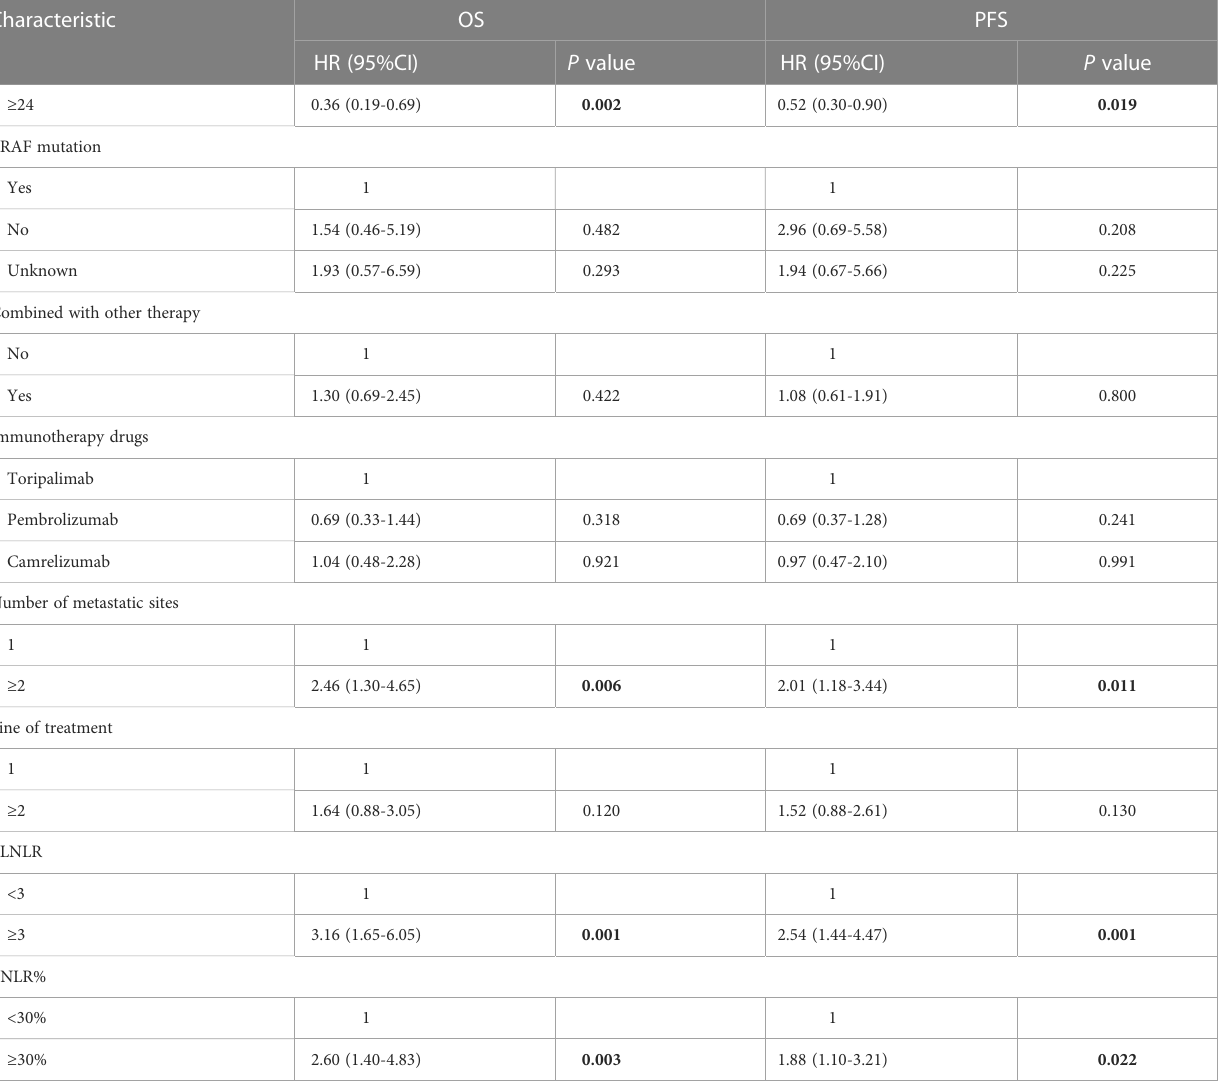
In a multivariate Cox regression model, BLNLR, D NLR%, BMI and number of metastatic organs were independent prognostic factors for OS (Table 3). The risk of mortality in the high-BLNLR group was 2.58 times higher than that in the low-BLNLR group (HR: 2.58, 95%CI: 1.21-5.52, P = 0.014). The risk of mortality in the high- D NLR% group was 3.76 times higher than that in the low- D NLR% group (HR: 3.76, 95%CI: 1.93-7.32, P < 0.001). BLNLR and D NLR% were independent prognostic factors for PFS (Table 3). The risk of disease progression in the high-BLNLR group was 2.20 times higher than that in the low-BLNLR group (HR: 2.20, 95%CI: 1.15- 4.18, P = 0.017). The risk of disease progression in the high- D